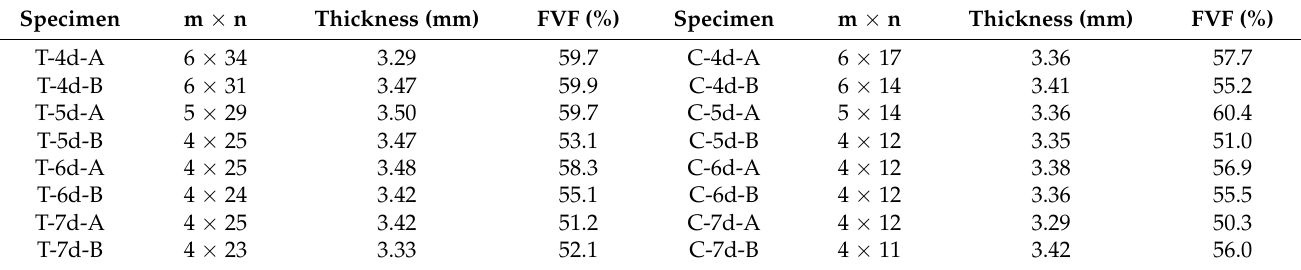
Table 2. Braiding parameters, thickness and FVF of specimens.